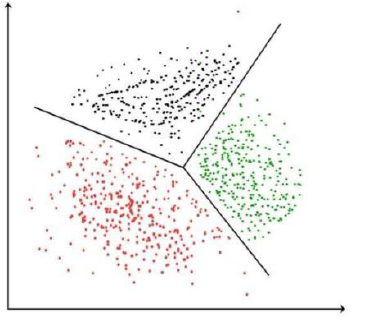
Figure 2. Non-Linear Separable clusters [3]